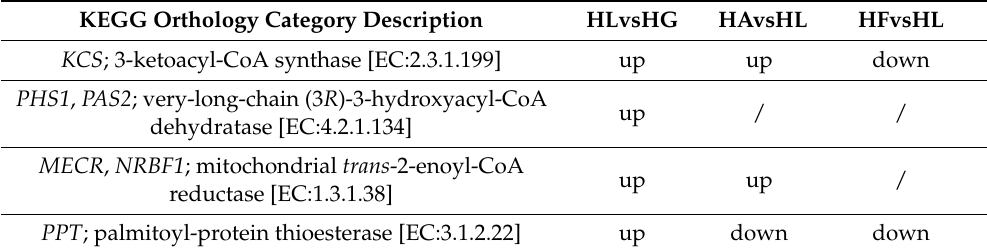
Table 5. The up-and-down regulated genes related to the fatty acid elongation pathways. KEGG Orthology Category Description